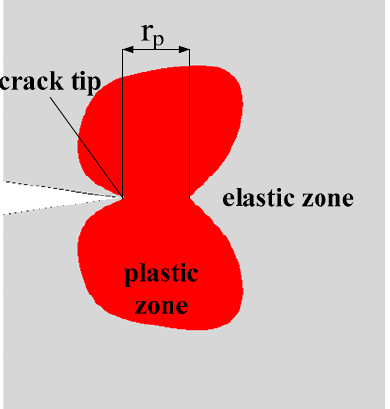
Figure 7. Schematic diagram of plastic zone r p . The r p values of 0.676421587 mm (37 pixels) and 0.647278593 mm (35 pixels) for specimen B1 a = 25.02 mm and specimen W1 a = 24.48 mm, respectively, were calculated